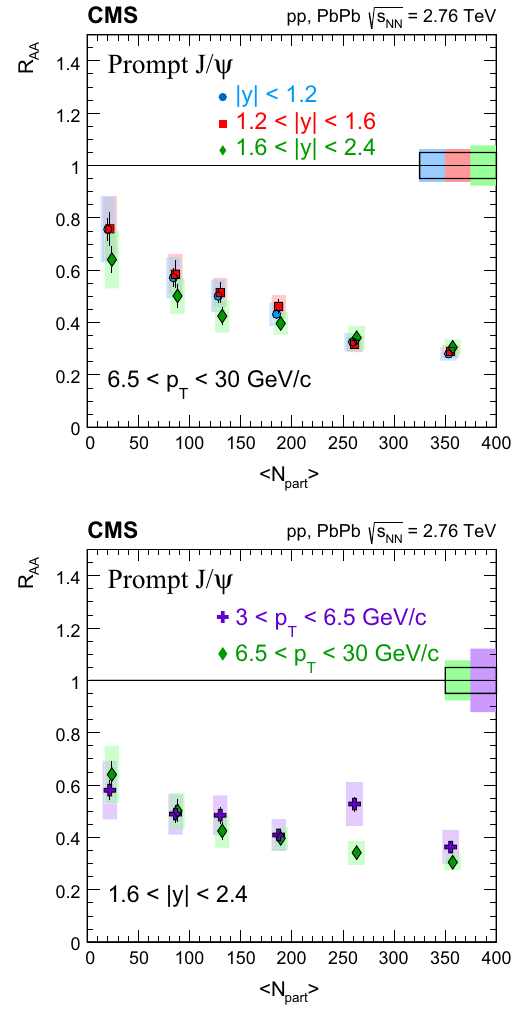
Fig. 5 Top Prompt J /ψ R AA as a function of centrality at high p T , 6 . 5 < p T < 30GeV / c,forthreedifferent | y | regions.Thehigh- p T mid- and forward-rapidity points are shifted horizontally by (cid:12) N part = 2 for better visibility. Bottom Prompt J /ψ R AA as a function of centrality, at forwardrapidity,1 . 6 < | y | < 2 . 4,fortwodifferent p T regions.The bars ( boxes ) represent statistical (systematic) point-by-point uncertainties. The boxes plotted on the right side at R AA = 1 represent the scale of the global uncertainties: the coloured boxes show the statistical and systematic uncertainties from pp measurement, and the open box shows the global uncertainties common to all data points. The average N part values correspond to events flatly distributed across centrality increasing with N part . The R AA for the most central events (0–5%) is measured for 6 . 5 < p T < 30 GeV / c and | y | < 2 . 4 to be 0 . 282 ± 0 . 010 (stat) ± 0 . 023 (syst). No strong rapidity